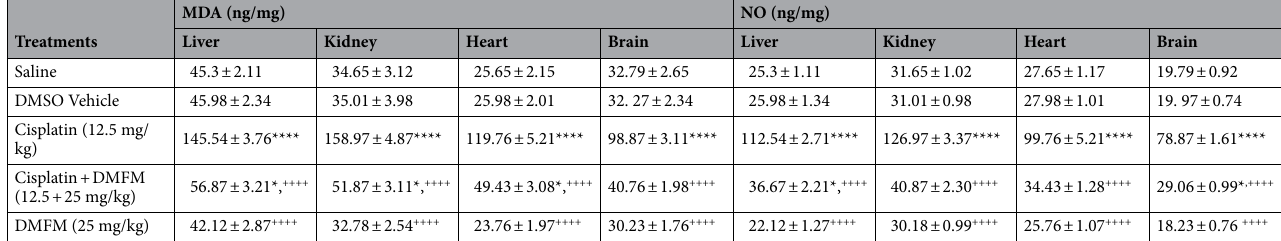
Table 3. Effect of treatment with MMINA on oxidative stress in cisplatin-treated rat organs. Data are mean ± SEM, (n = 7). *, **** p < 0.05 and P < 0.0001 versus Control respectively, and ++++ P < 0.0001 versus CP. Data analyzed by One-way ANOVA followed by Tukey’s multiple comparison tests.